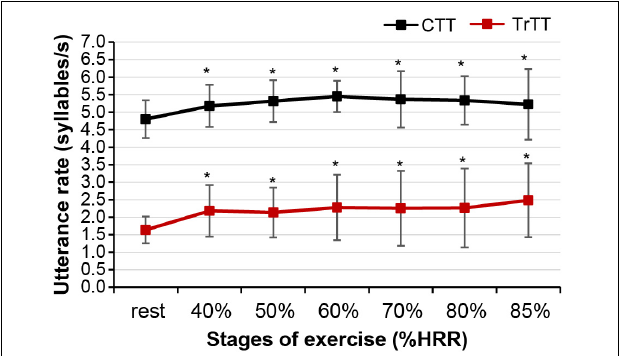
FIGURE 4 | Mean utterance rates in the CTT and tMTT as represented by markers and standard deviation represented by error bars at the resting stage and incremental stages of exercise. Asterisks (*) denote significant differences in the utterance rate between the resting state and the respective stages of incremental exercise at a 0.05 significance level.